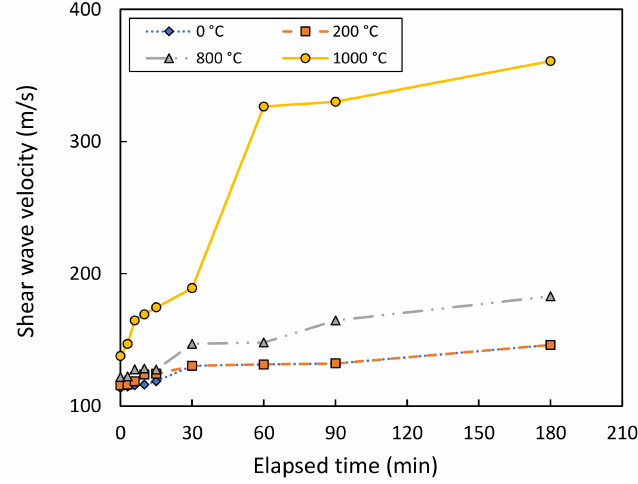
Figure 7. Shear wave velocity vs. the elapsed time of bender element testing, measured at different treatment temperatures.